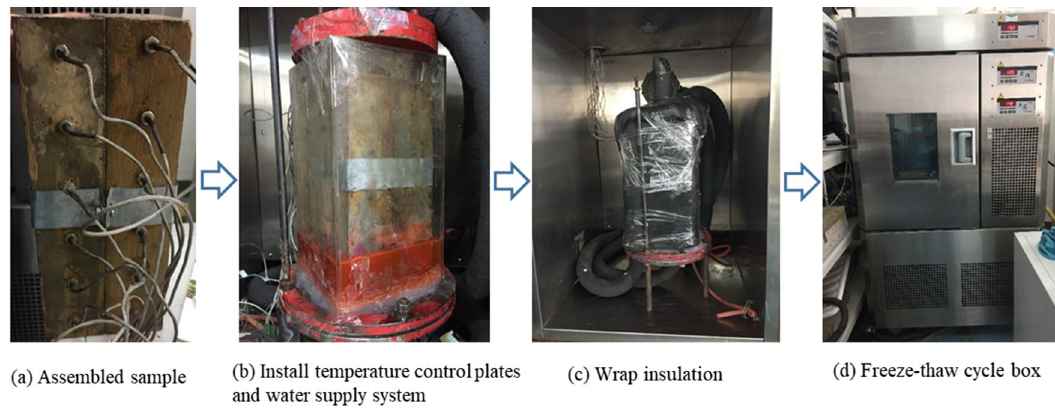
Figure 4. Test procedure.